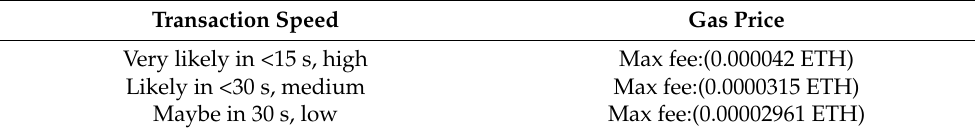
Table 5. The relationship of both acceptance speed and gas price among the